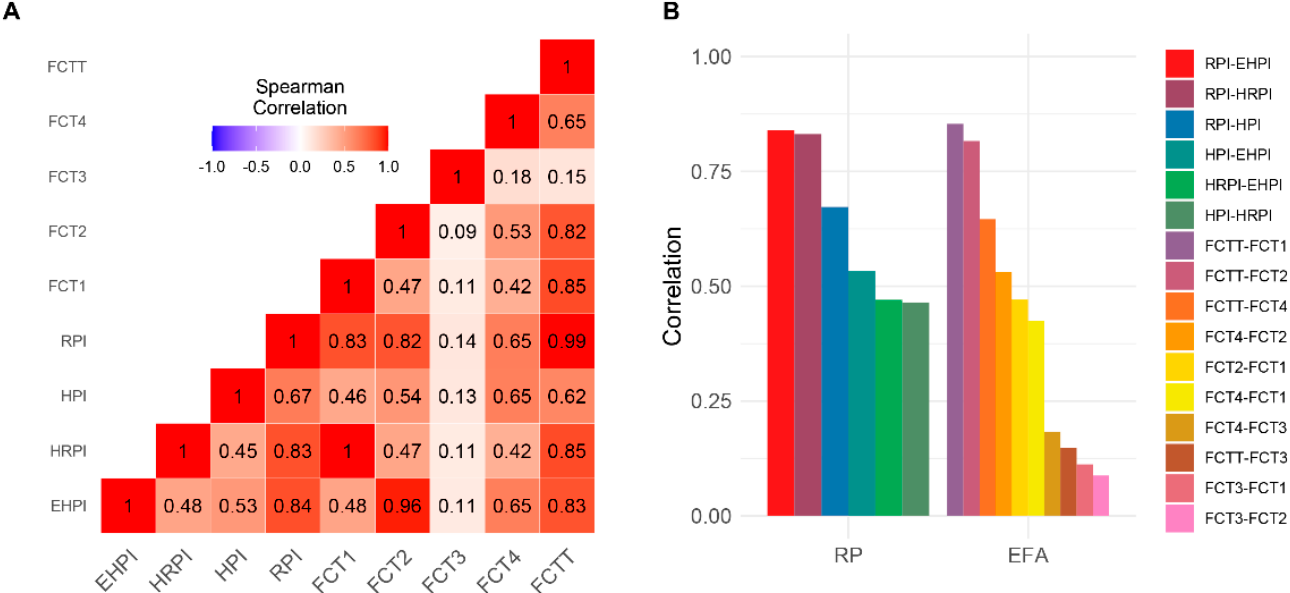
Figure 1. Pairwise correlations between each couple of risk perception (RP) indices and exploratory factorial analysis (EFA) indices. Panel ( A ) shows the Spearman pairwise correlations between each pairing of indices (RP and EFA), whereas Panel ( B ) shows the intra-set correlation values for each set of indices. EHPI: exposure hazard perception index; HRPI: health risk perception index; HPI: hazard perception index; RPI risk perception index. FCT1–4: exploratory factor analysis factors.